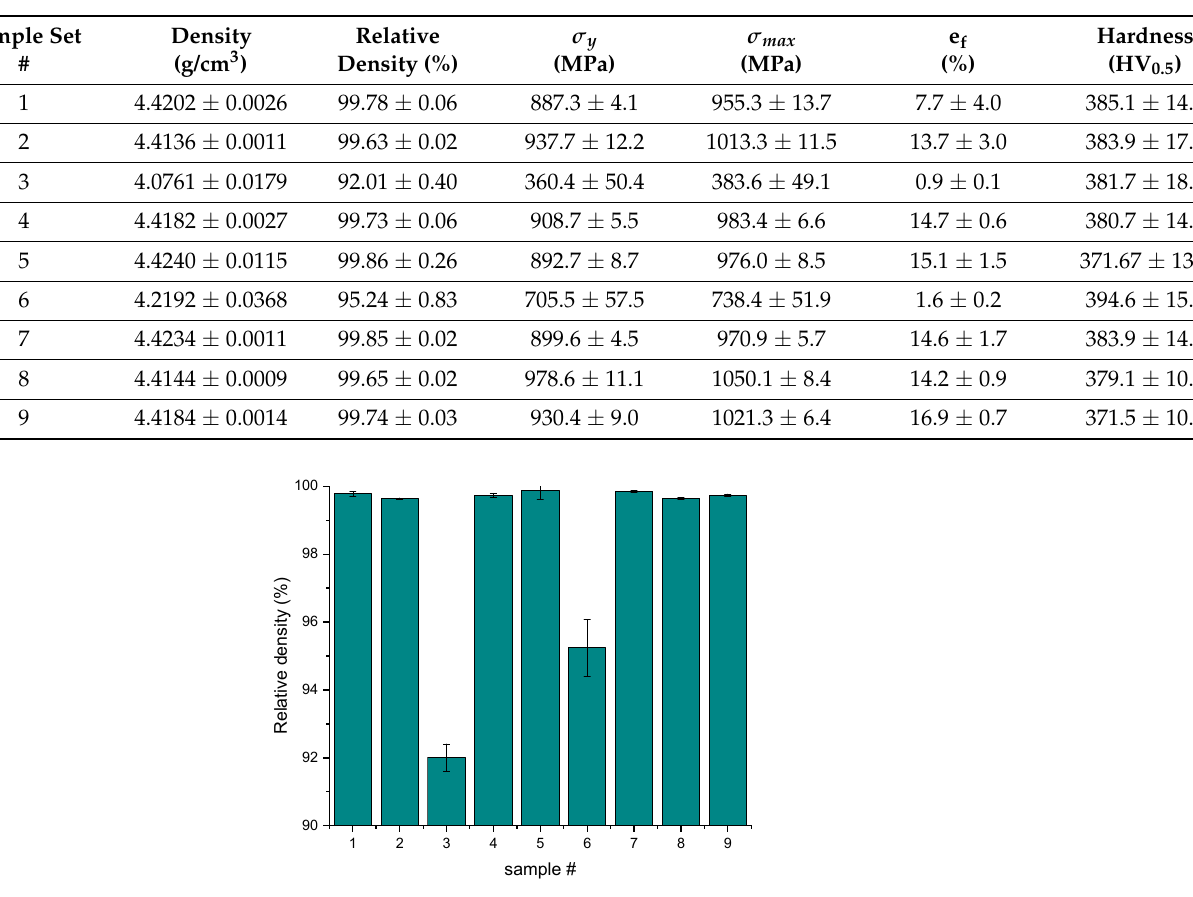
Table 4. Density, relative density, yield strength, ultimate tensile strength, elongation at break, and hardness values.